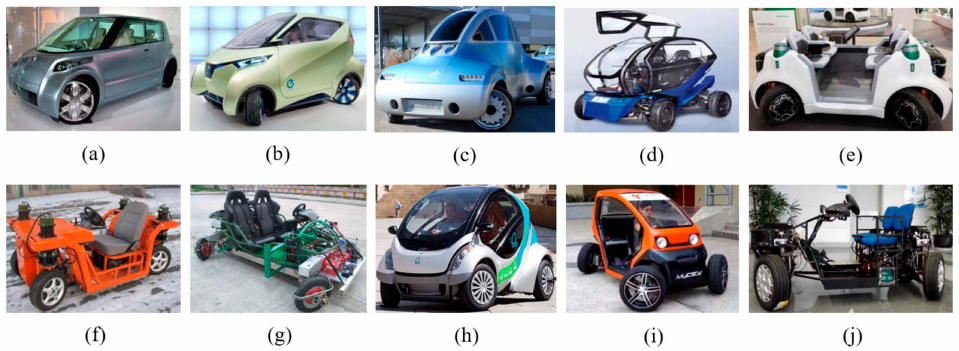
Figure 2. Protypes of 4WID-4WIS EV: ( a ) Toyota Fine-T; ( b ) Nissan PIVO3; ( c ) ROboMObil; ( d ) DFKI EO Smart 2; ( e ) Schaeffler Mover; ( f ) Jilin University; ( g ) CUHK OK-1; ( h ) MIT Hiriko; ( i ) UTM; ( j ) Tongji